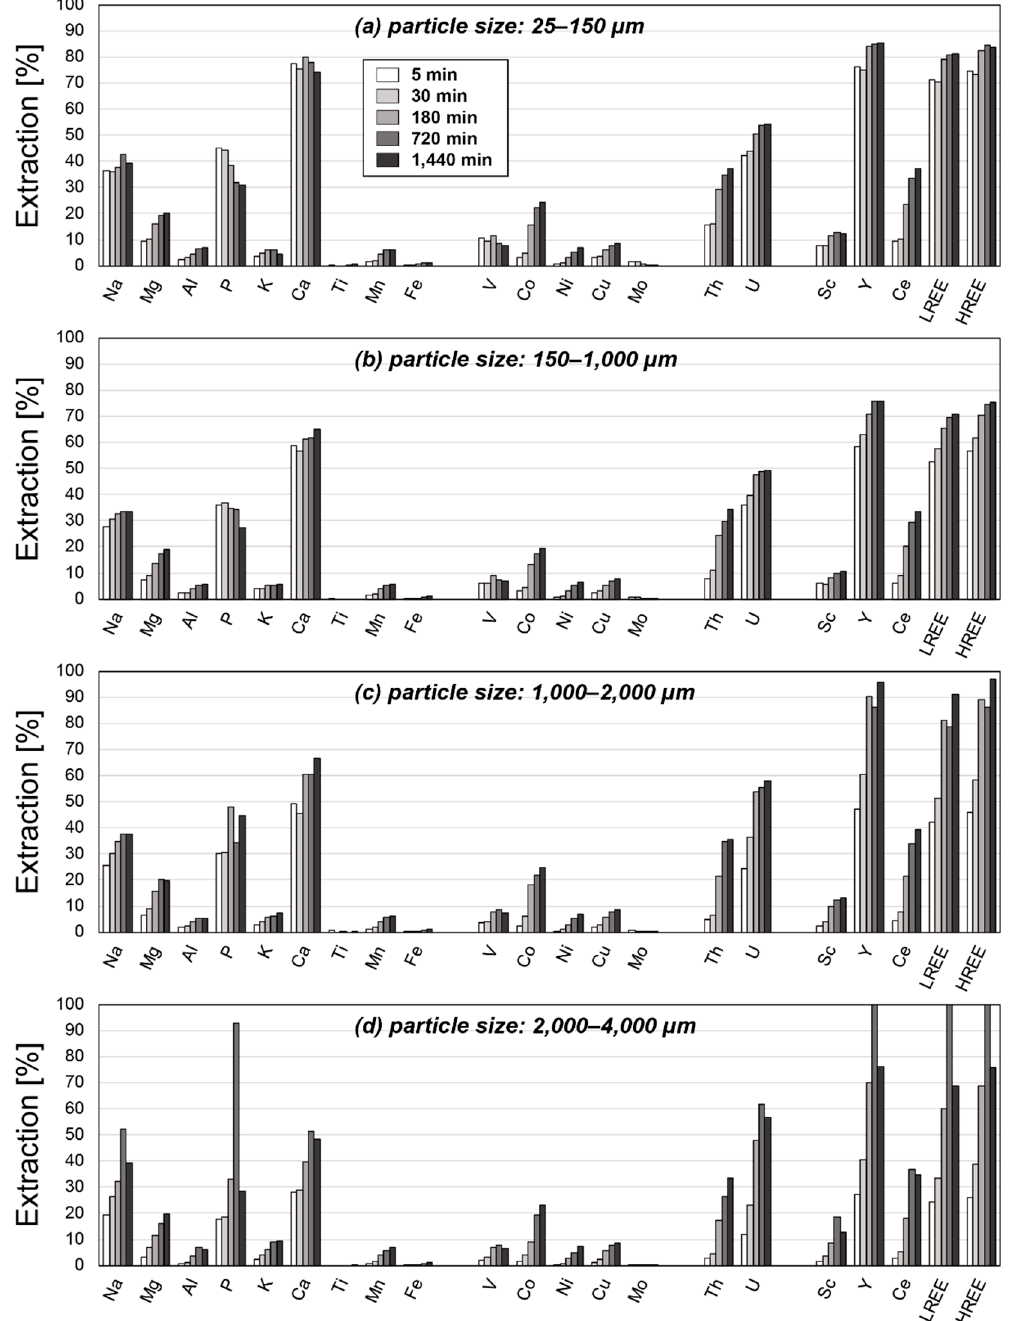
Figure 8. Extraction percentages of major elements, valuable metals, radioactive elements, and REE from the Cyprus umber as a function of time using sulfuric acid as a leachate. Experiments with the particle size of ( a ) 25–150 μ m, ( b ) 150–1000 μ m, ( c ) 1000–2000 μ m, and ( d ) 2000–4000 μ m.